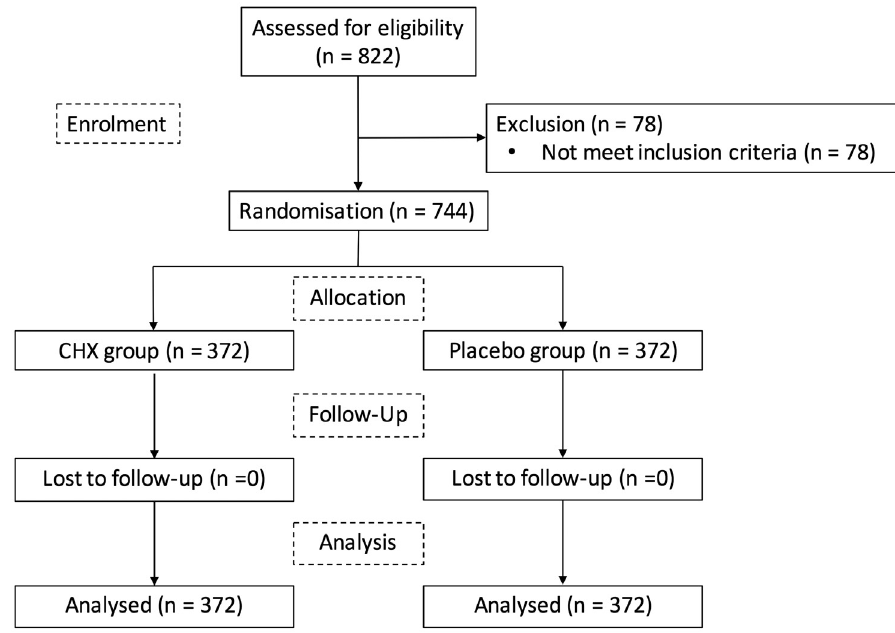
Figure 1- CONSORT flow diagram of patients included in the final